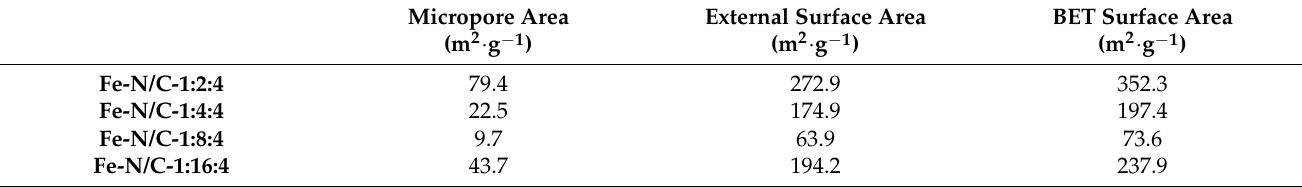
Table 2. The summary of the BET specific area of Fe-N/C-1:2:4, Fe-N/C-1:4:4, Fe-N/C-1:8:4, and Fe-N/C-1:16:4. Micropore